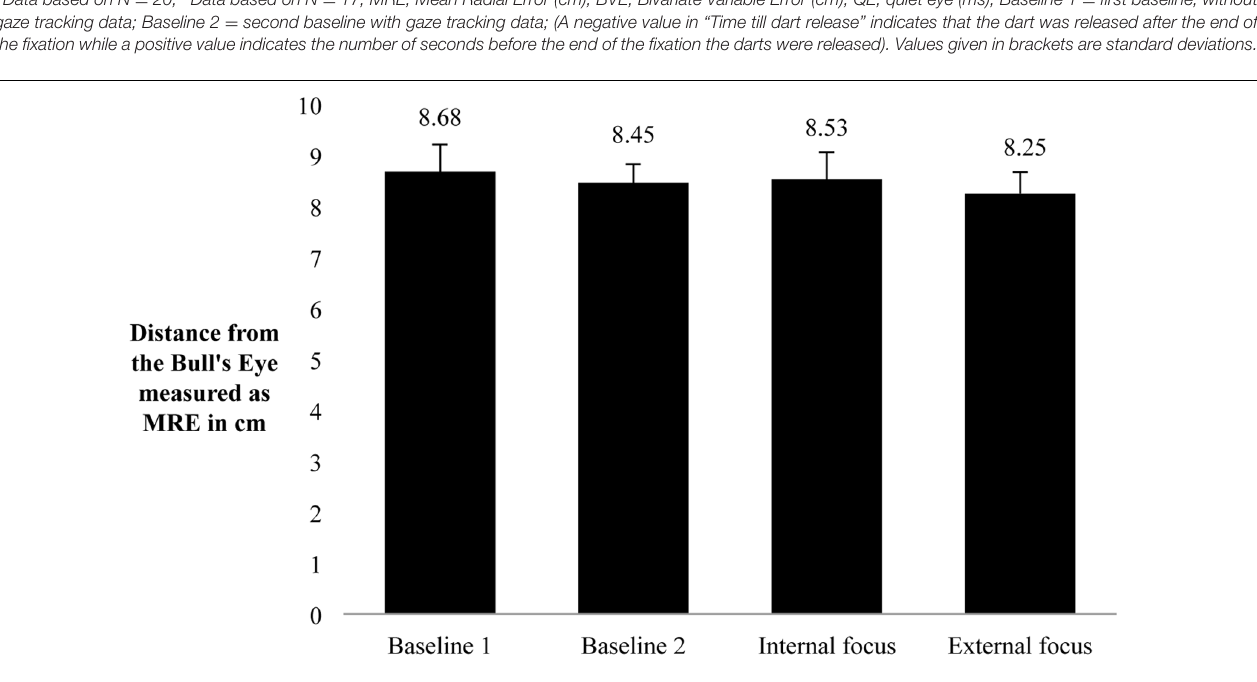
measured as RE were revealed. All correlations were between − 0.04 < r < 0.08 with all p > 0.05.